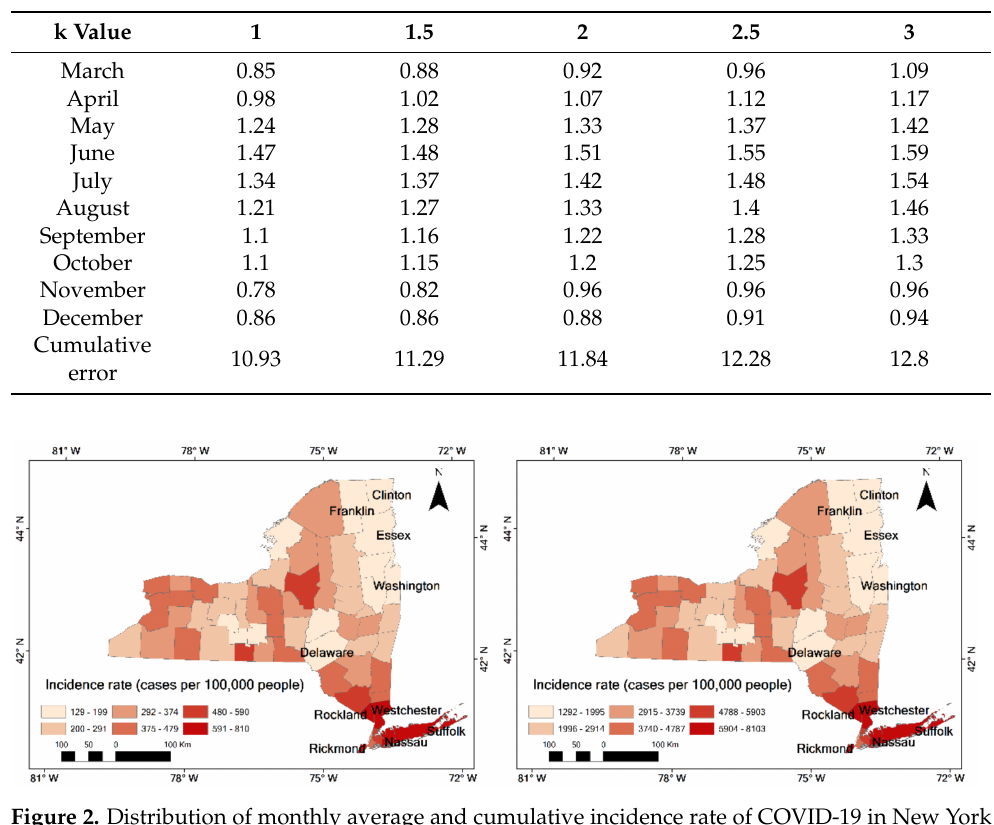
Table 2. RMSE of IDW interpolation with different k values.